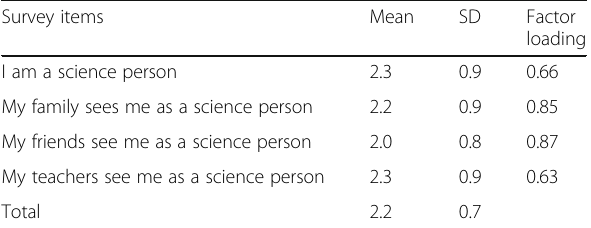
Table 2 Mean, SD, and EFA factor loadings of the science identity